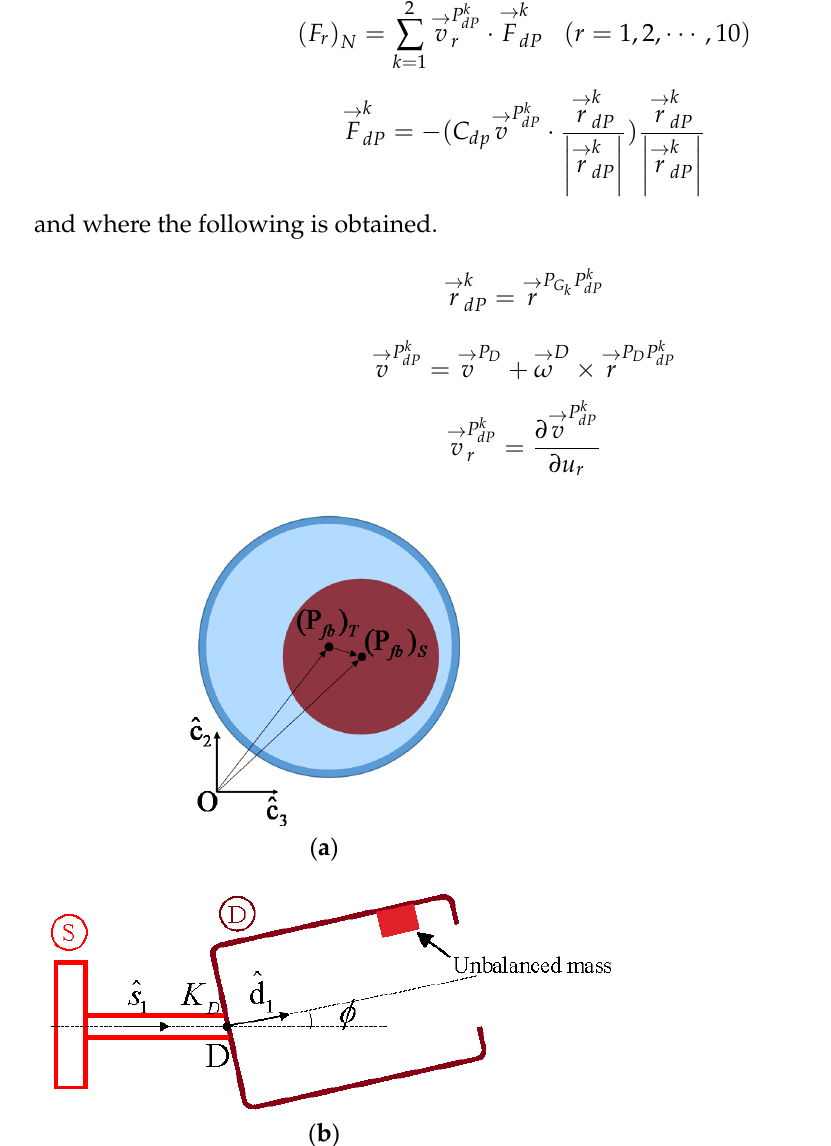
Figure 5. Relative translational and angular displacements ( a ) Relative displacement between bearing centers and ( b ) Relative angular displacement between body S and body D.